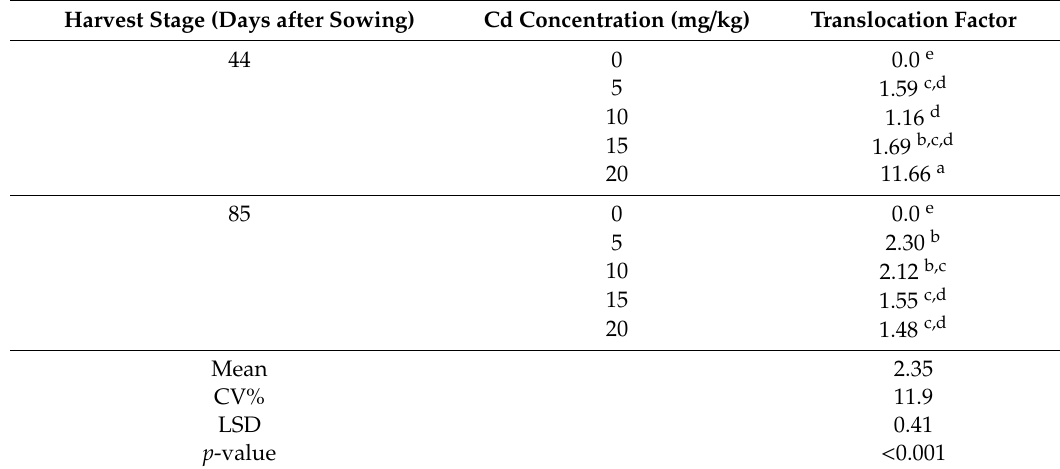
Table 4. Translocation of cadmium from roots to aerial parts of C.